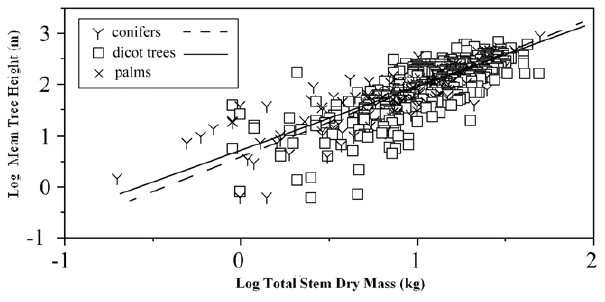
Figure 11. Bivariate log-log plot of tree H mean against total stem, mass. Data shown for conifers, angiosperm trees and palms documented in Cannell (1982) and Luo (1996).